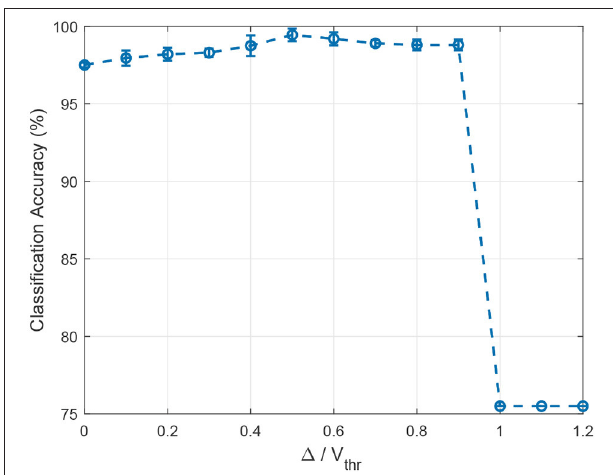
FIGURE 8 | The effect of the ratio between the hard margin 1 and the firing threshold V thr on classification accuracy. For 1/ V thr reduced to the standard Tempotron rule. The hard margin 1 improves the classification accuracy for ratios below 1.0, while the accuracy drops significantly afterward. The best accuracy is achieved with a ratio of 0.5 on the RWCP